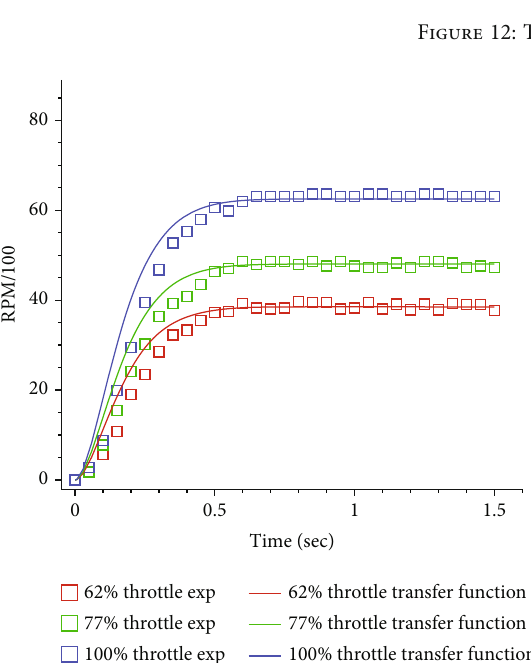
Figure 13: Comparison between the transfer function and the test data of the dynamic characteristics of the electric quadrotor system.